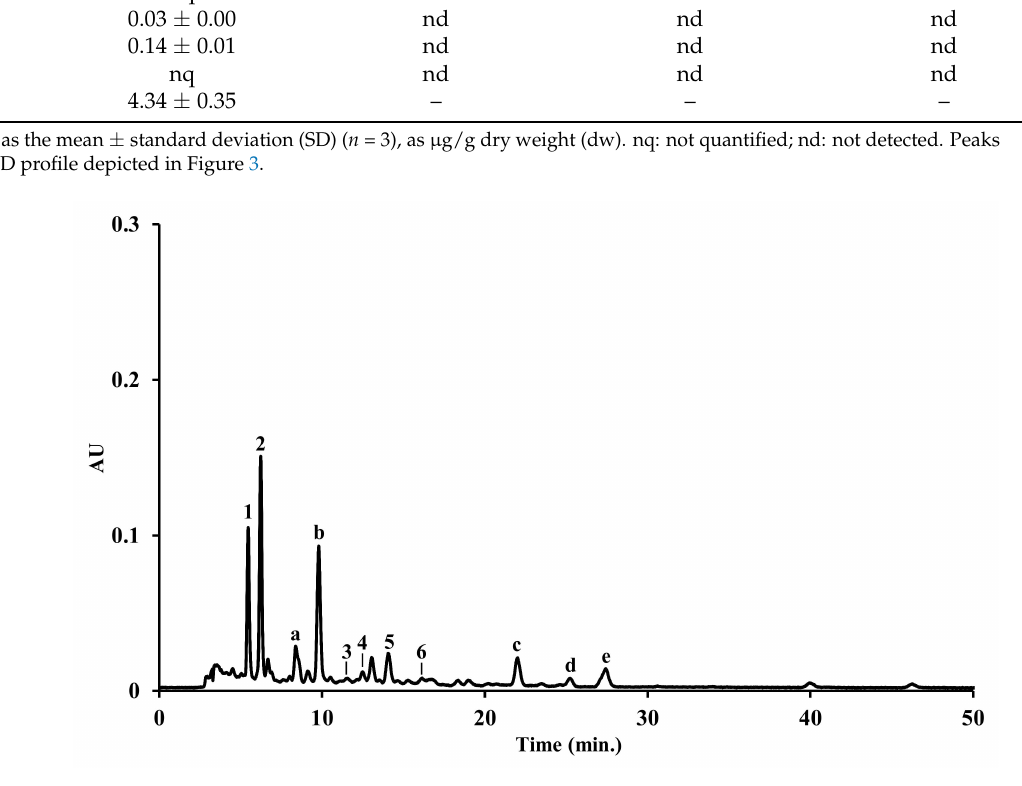
Figure 3. HPLC-DAD carotenoid profile of the dichloromethane extract from Microcosmus squamiger . Identity of compounds as in Table